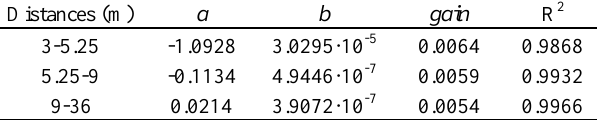
Table 2. Empirical calibration coefficients of the Faro